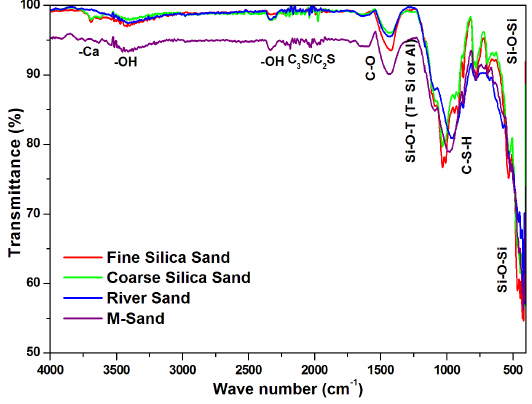
Figure 22. Comparison of FTIR